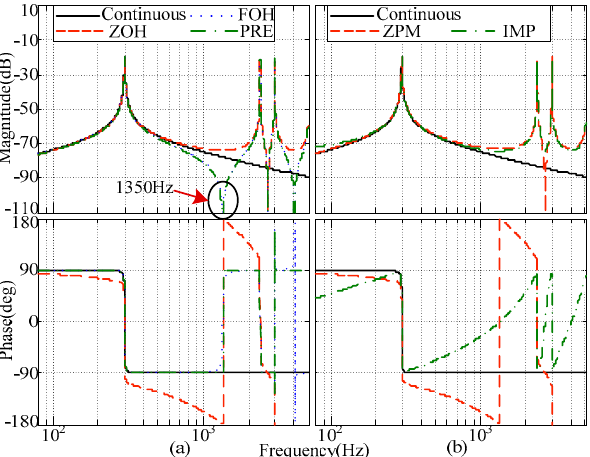
Figure 10. Bode diagram of Types C and D. ( a ) ZOH / FOH / PRE; ( b ) ZPM / IMP.